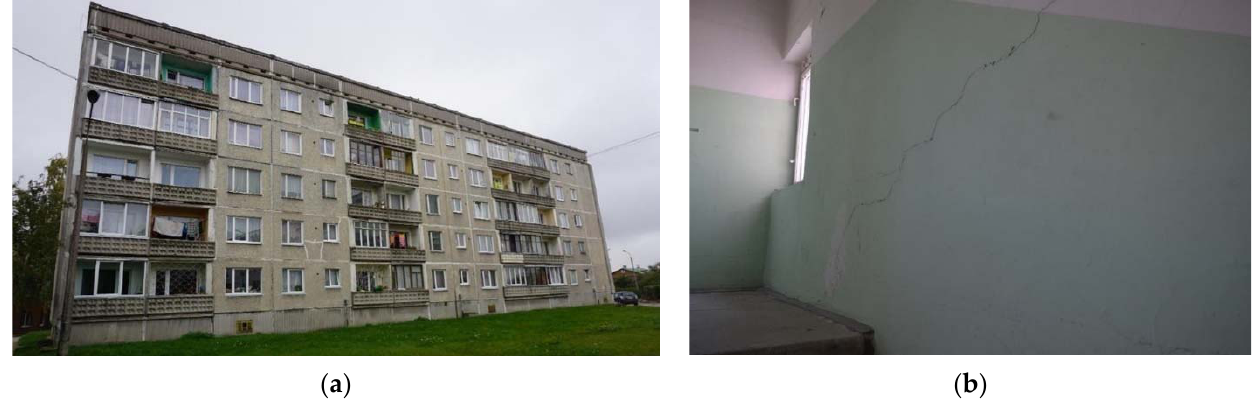
Figure 9. Cracks in residential buildings: ( a ) cracks in building façade panels; ( b ) cracks in building loadbearing walls.